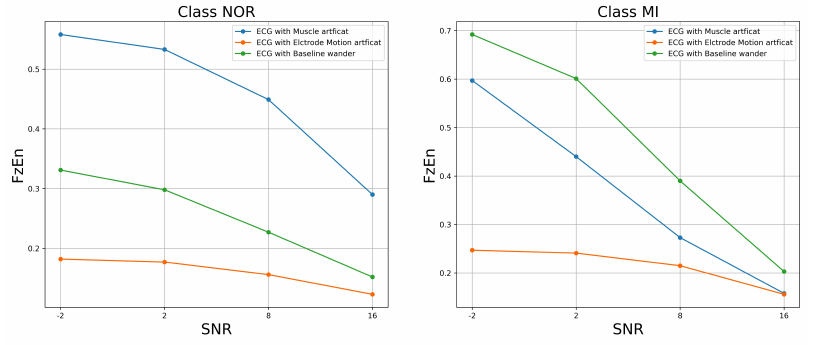
Figure 8. FzEn versus SNR of the ECG-filtered signal with added